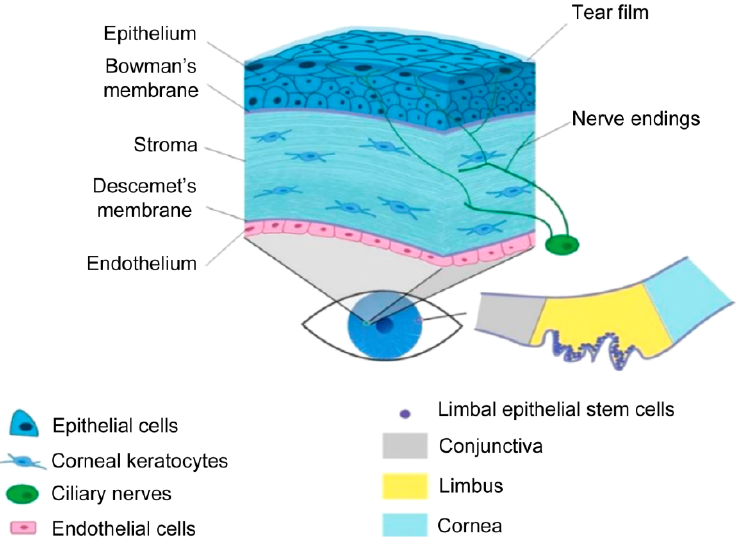
Figure 3. Anatomy of the cornea. Reproduced with permission from [20], Elsevier, 2019. The corneal epithelium is composed of a few layers of epithelial cells that form the outermost area of the cornea. The epithelial cells are constantly renewed from the basal layer, which is formed by limbal stem cells (LSCs) [31,32]. However, any damage in the basal area would lead to a dysfunction of the LSCs that would result in overgrowth of the conjunctiva and blood vessels, photophobia and pain [32]. The Bowman’s membrane is a thin acellular layer that separates the epithelium from the stroma [31]. The stroma is the widest part of the cornea. It is composed of laminin and collagen I fibrils that align perfectly to form a complex structure. This structural complexity is the key to its transparency and mechanical resistance [33,34]. In addition, it is composed of keratinocyte cells, which are responsible for maintaining the ECM [31]. These cells have little mitotic activity and present dendritic morphology. Nevertheless, in case of trauma, they are activated as a fibroblast that can differentiate into myofibroblasts [34,35]. Myofibroblasts express proteins that can alter the ECM causing opacity of the cornea, contraction and a corneal scar formation [31,35]. Descement’s membrane is an acellular layer that separates the stroma from the endothelium [31]. The endothelium is the deepest layer and is composed of endothelial cells that are responsible for maintaining the fluid balance of the cornea [31]. They have very little capacity of regeneration in vivo, therefore any damage in this area would cause irreversible blindness [36].